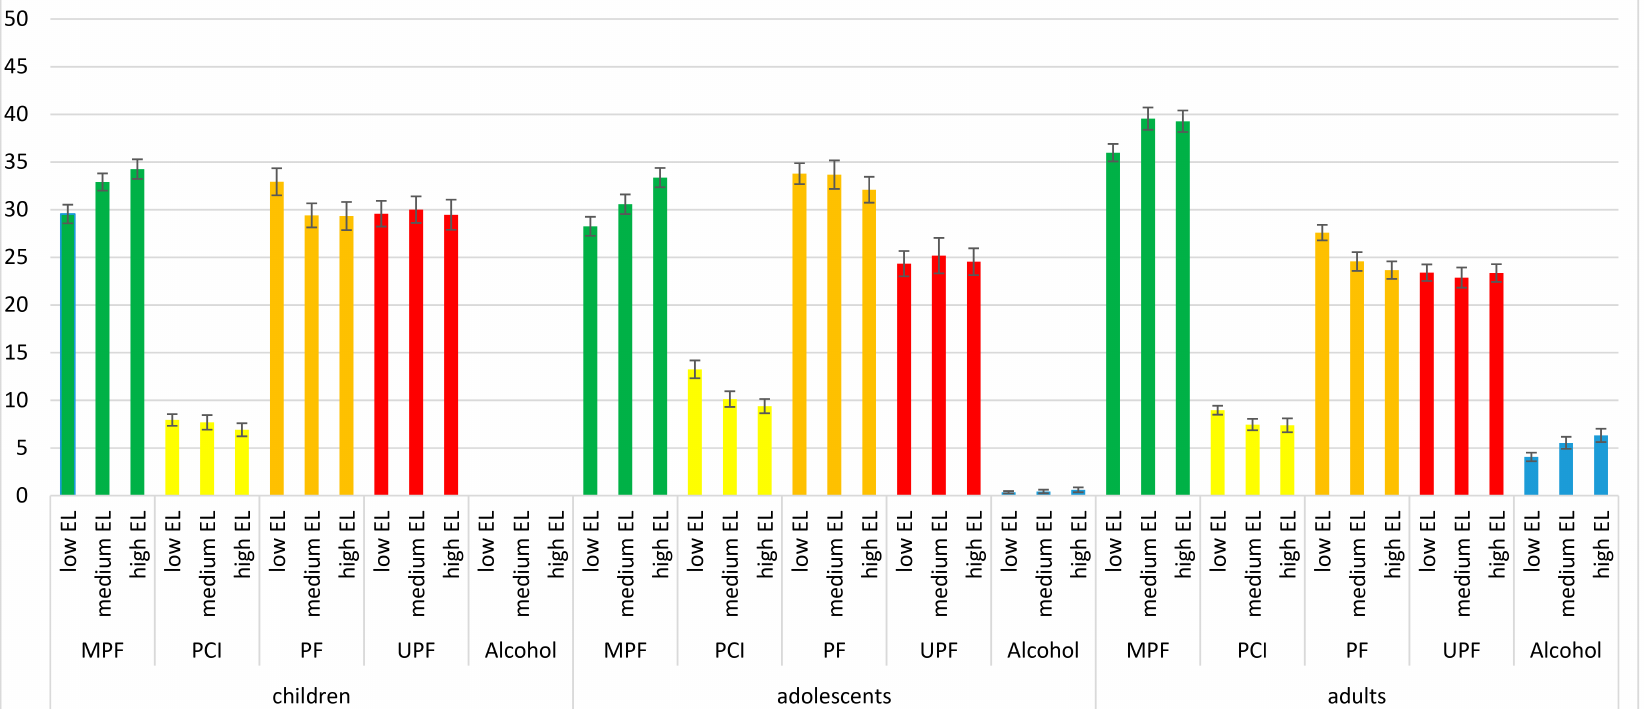
Figure 2. Contribution (average % ± SE) of unprocessed / minimally processed foods (MPF), processed culinary ingredients (PCI), processed foods (PF), ultraprocessed foods (UPF) and alcohol to the cost of diets (total cost / day) by age group and socio-economic status (education level (EL) of the